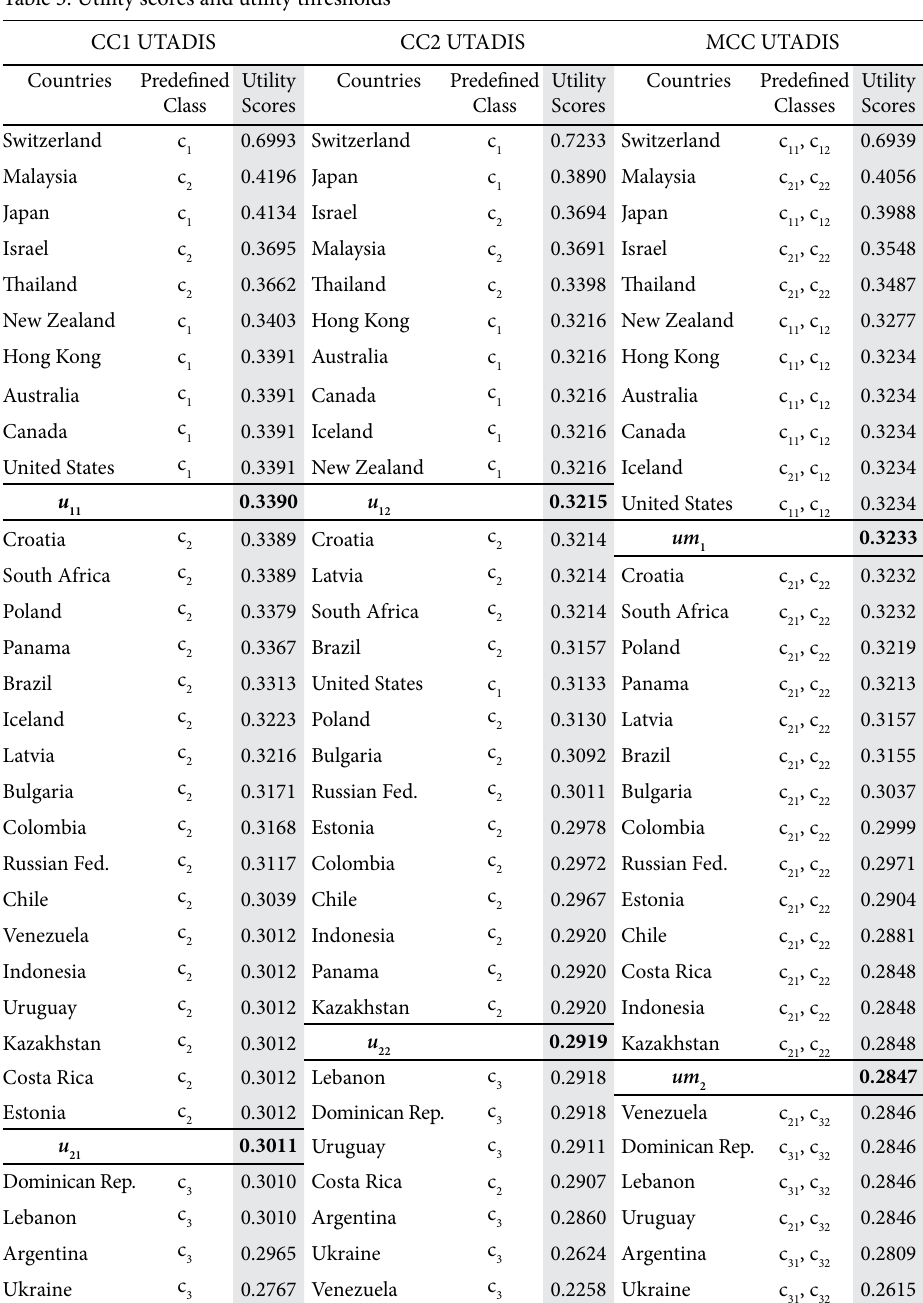
table 3. Utility scores and utility